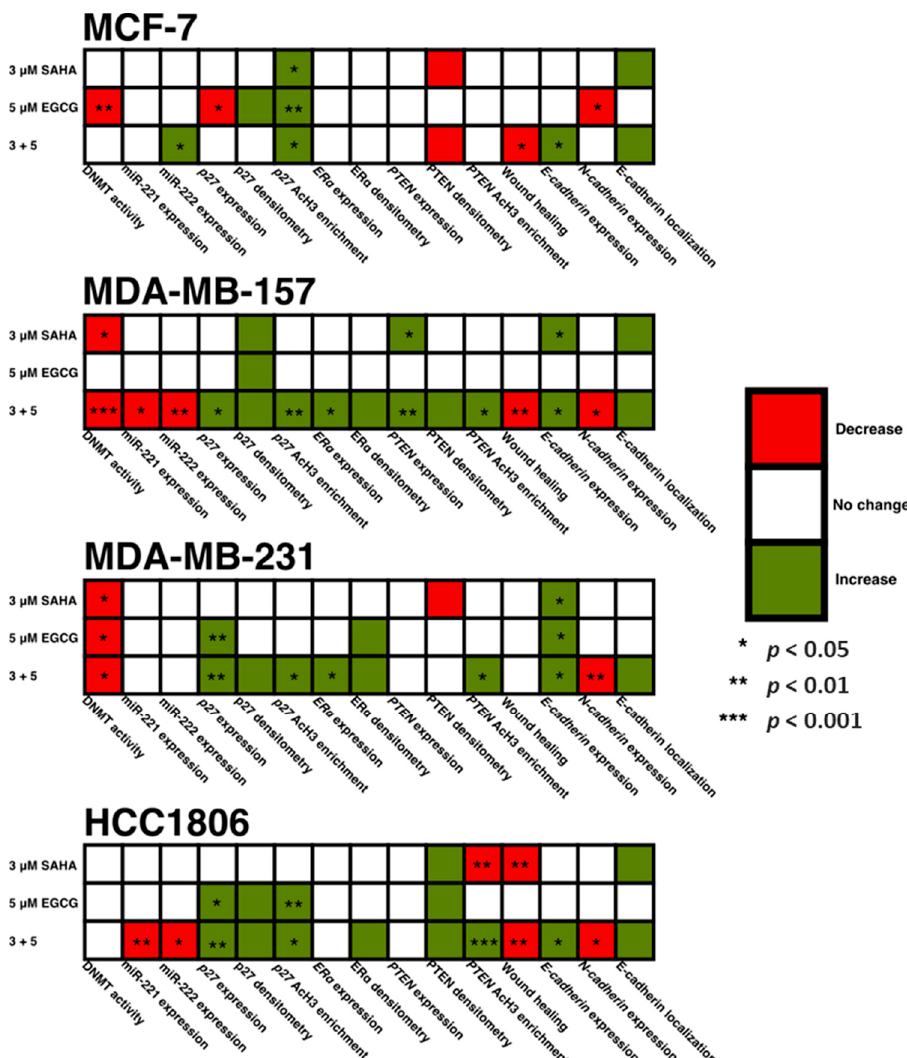
Figure 15. A summative figure visualizing the findings from the present study. Despite all four cell lines demonstrating a decrease in cell density and growth in Figure 1, there is variance in the mechanisms behind the decrease. The heterogeneity of TNBC is easily visualized in this figure, which can represent the importance of epigenetic-based treatment of TNBC.